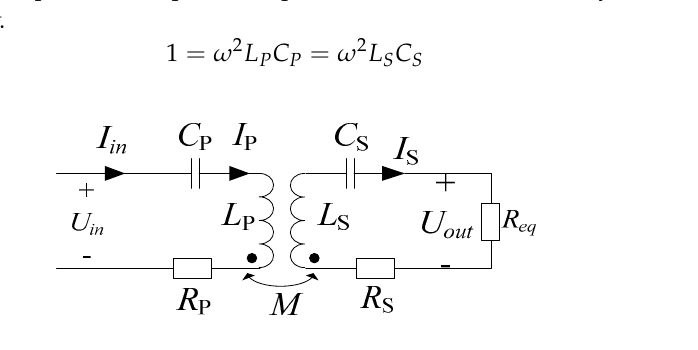
Figure 3. SS compensation equivalent circuit.